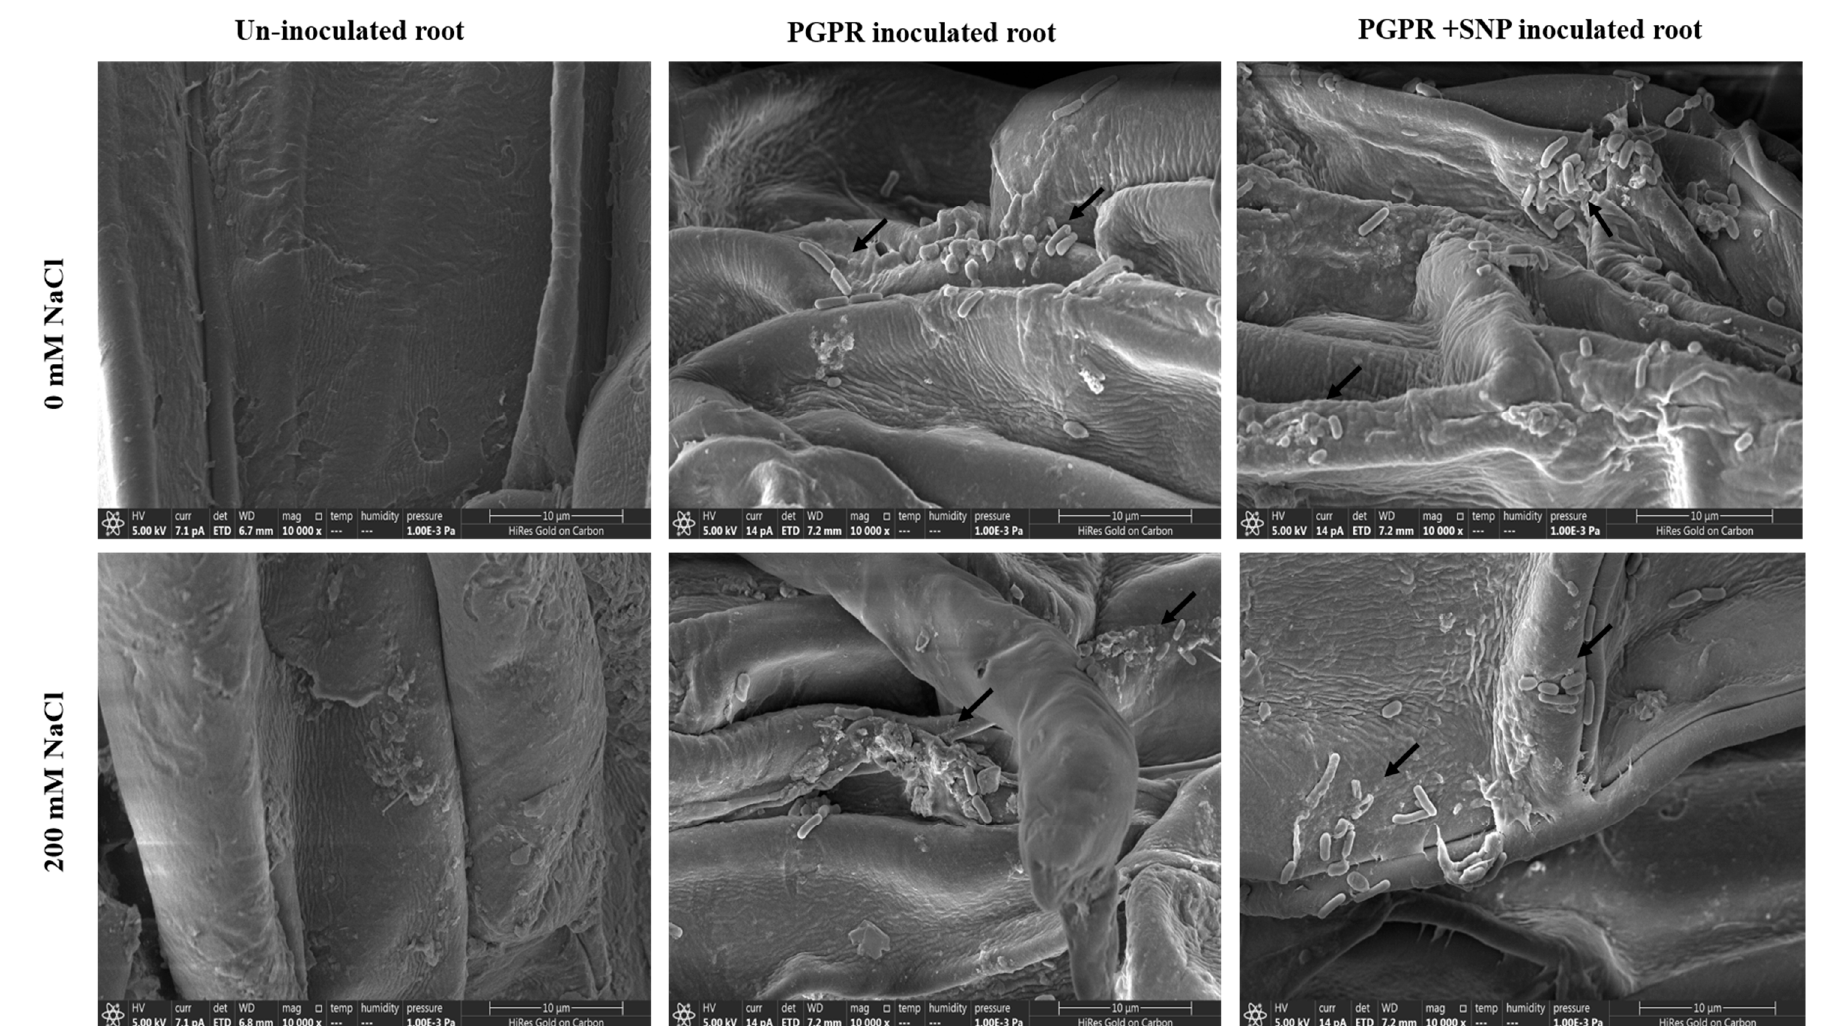
Figure 10. Scanning electron microscopic image showing root colonization and biofilm formation of salt-tolerant PGPR strain ASN-1 under NaCl and SNP modifications.